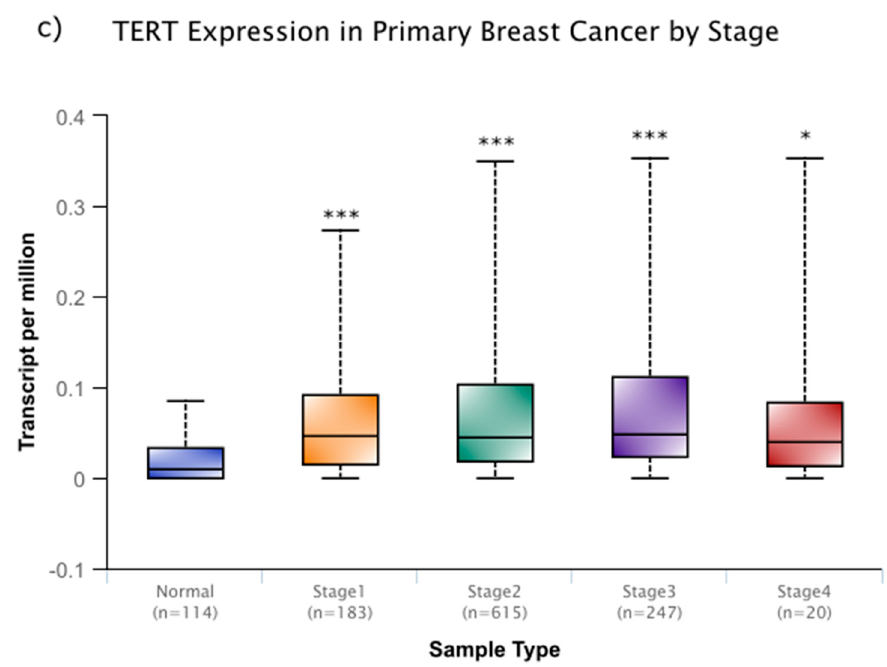
Figure 1. Telomerase reverse transcriptase ( TERT) expression of colon adenocarcinoma ( a ), and head and neck squamous carcinoma ( b ), and primary breast cancer ( c ) within the publicly available National Cancer Institute Genomic Data Commons. In ( c ), TERT expression data is expanded based on stage of breast cancer sampled. While there is no significant difference among cancer stages, each stage of cancer displays significantly higher expression than normal tissue. Data were accessed through the University of Alabama at Birmingham UALCAN cancer transcriptome database (http://ualcan.path.uab.edu) [20]. These box and whisper plots encompass all transcriptome data recorded, with the upper and lower bars giving the total range of data recorded. The bolded middle line represents the mean of the data, and the second and third quartiles are contained within the box. Significance in relation to normal tissue is denoted by asterisks, with * representing a p < 0.05 and *** representing a p < 0.001. These types of cancer ( a , b , & c ) were chosen for their relatively high sample sizes, but these trends carry across many other cancer types.